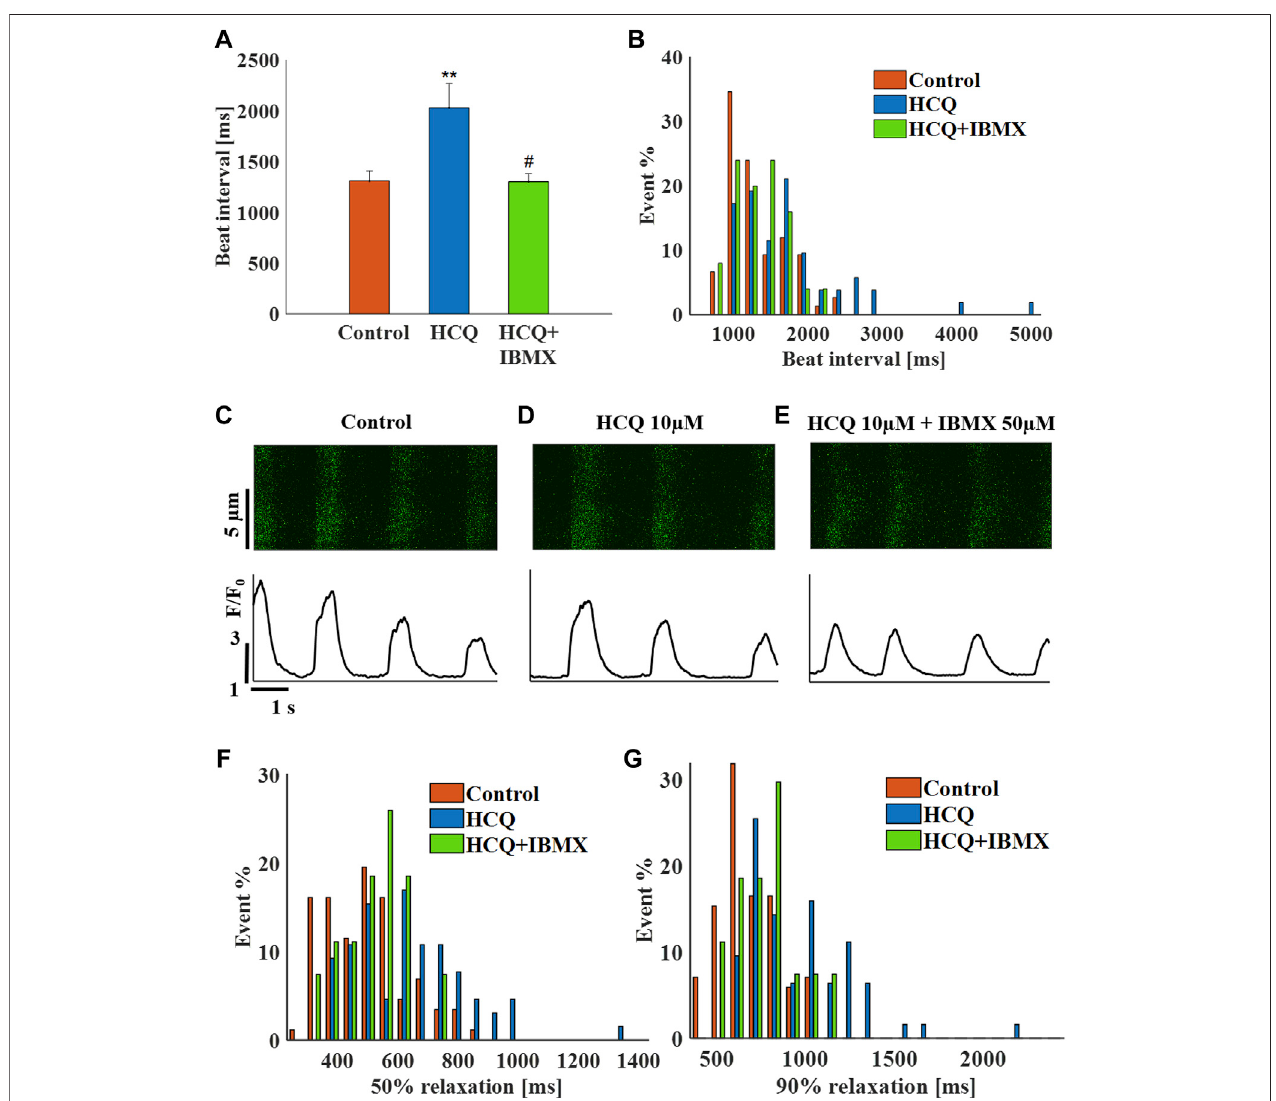
FIGURE 7 | The effect of hydroxychloroquine (HCQ) with 3 ′ -isobutylmethylxanthine (IBMX) on human induced pluripotent stem cell – derived cardiomyocytes. (A) Meanbeatinterval and (B) beatingintervaldistributionofcontrol and of10 μ MHCQ-( n = 18)or 10 μ M HCQ and 50 μ M IBMX-treated ( n =6) human inducedpluripotent stem cell – derived cardiomyocytes (hiPSC-CMs). Representative example of Ca 2+ transients in (C) control and in (D) 10 μ M HCQ- or (E) 10 μ M HCQ and 50 μ M IBMX- treatedhiPSC-CMs.Thedistributionof (F) 50%and (G) 90%Ca 2+ transientrelaxationtimesincontrolandin10 μ MHCQ-or10 μ MHCQand50 μ MIBMX-treated hiPSC-CMs. ** p < 0.01 vs. baseline, # p < 0.05 vs. 10 μ M